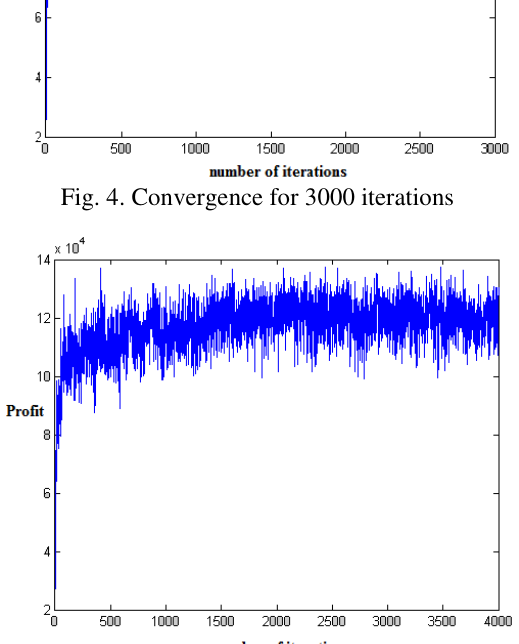
Fig. 2. Convergence for 1000 iterations